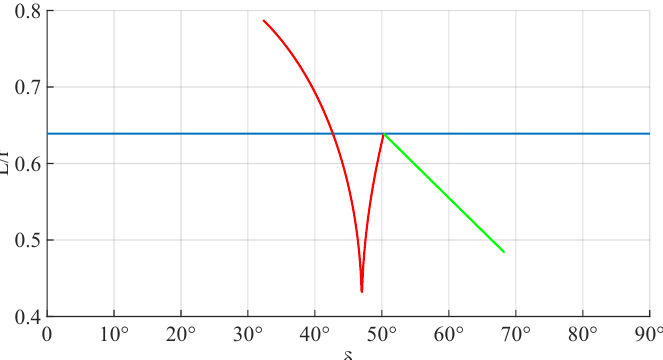
Figure 10. Contact distance under transformable state C 1 and C 2 L / r (15 mm) (Blue: wheel state; Red: C 1 ; Green: C 2 ).